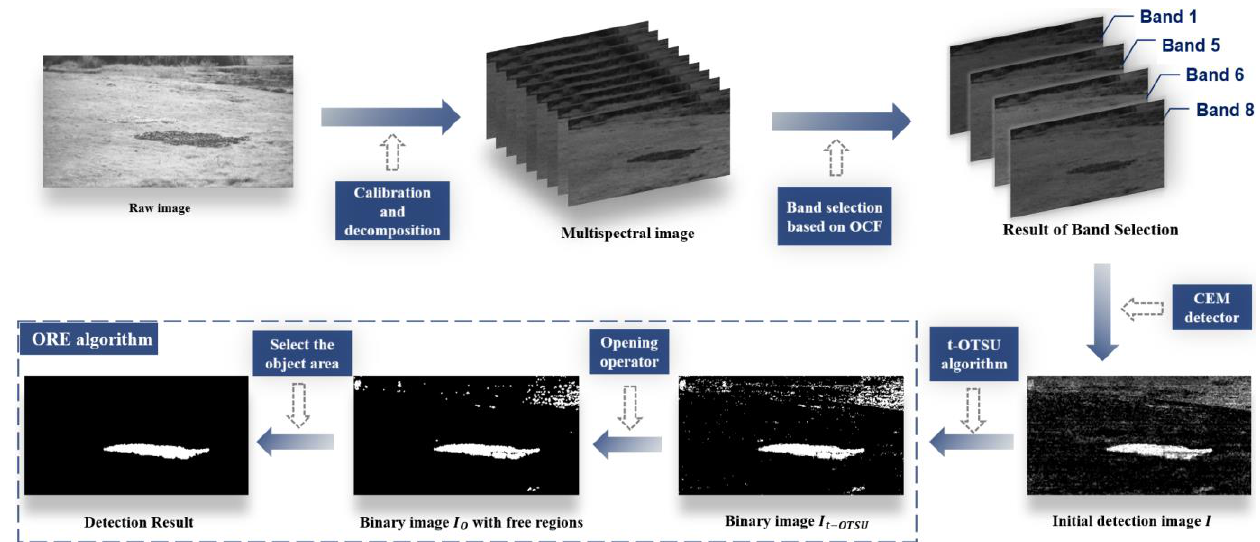
Figure 1. The flow chart of the proposed camouflaged target detection method.